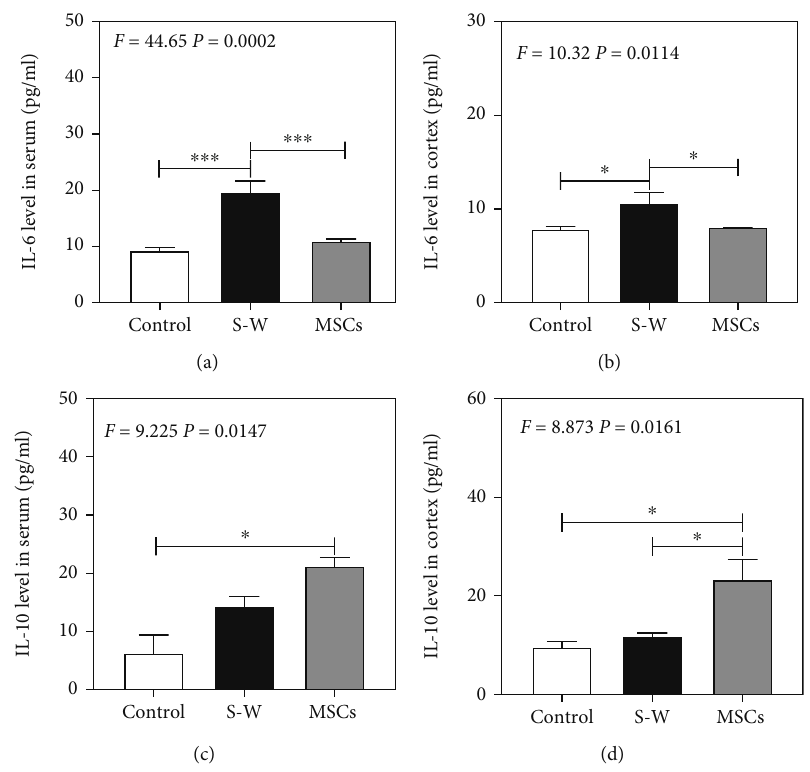
Figure 2: The expression of IL-6 and IL-10 in serum and cortex at 6 hours after surgical wound and the in fl uence of UC-MSCs. (a, b) The expression of IL-6 at di ff erent groups after surgical wound in serum and cortex. (c, d) The expression of IL-10 at di ff erent groups after surgical wound in serum and cortex. N = 3 in each group ( ∗ p < 0 : 05 , ∗∗∗ p < 0 : 001